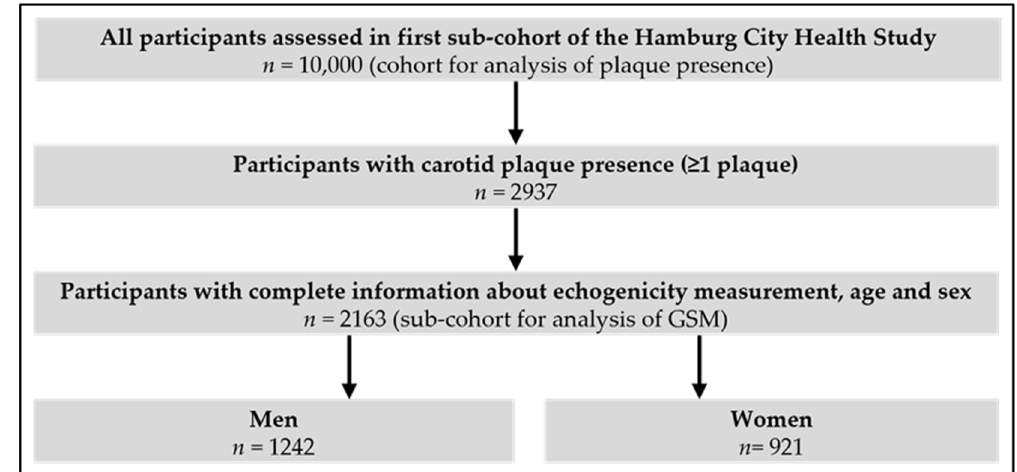
Figure 1. Flow Chart for assessment of echogenicity measurement in participants of HCHS. Table 1. Baseline characteristics of the study population of GSM-sub-cohort.